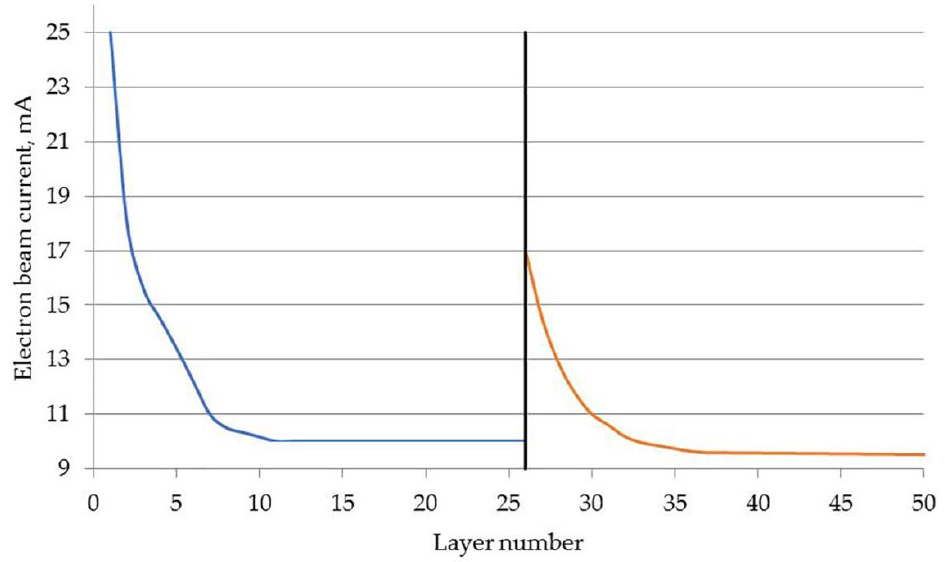
Figure 2. Schematic of the repair process using electron-beam additive technology. For the additive formation of such products, the parameters of the wire-feed elec- tron beam manufacturing process achieved during previous studies were used [16,17]. When forming the initial and repaired walls, the invariable parameters were the speed of the working table movement — 20 mm/min and the accelerating voltage — 30 kV. The variable parameter was the beam current, shown in Figure 3.